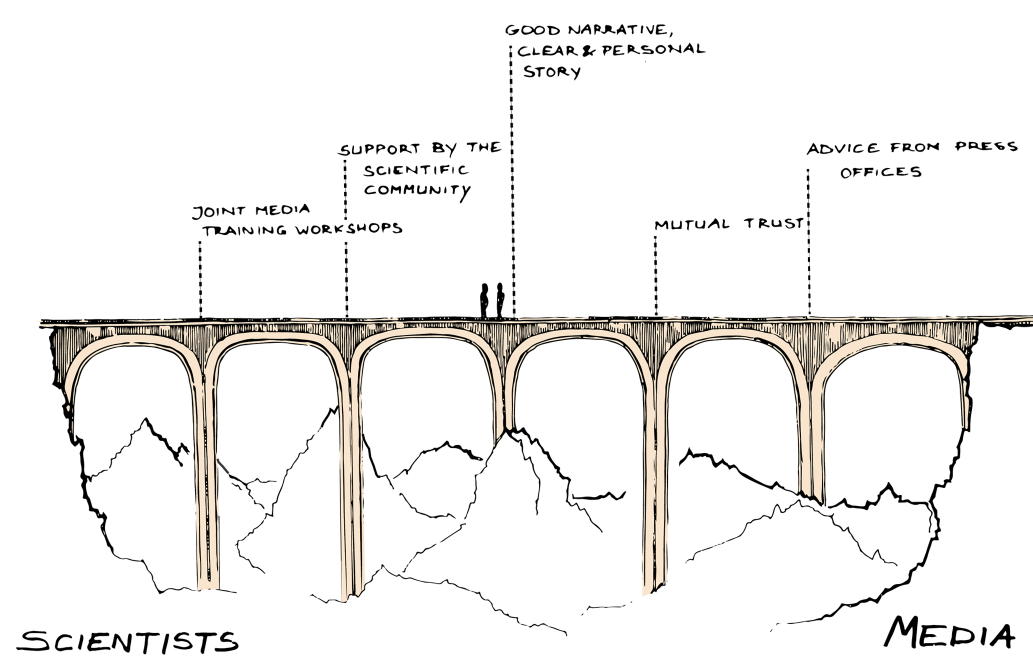
Figure 4. Summary of the tools and success factors for effective science–media communication (figure by Cher van den Eng).